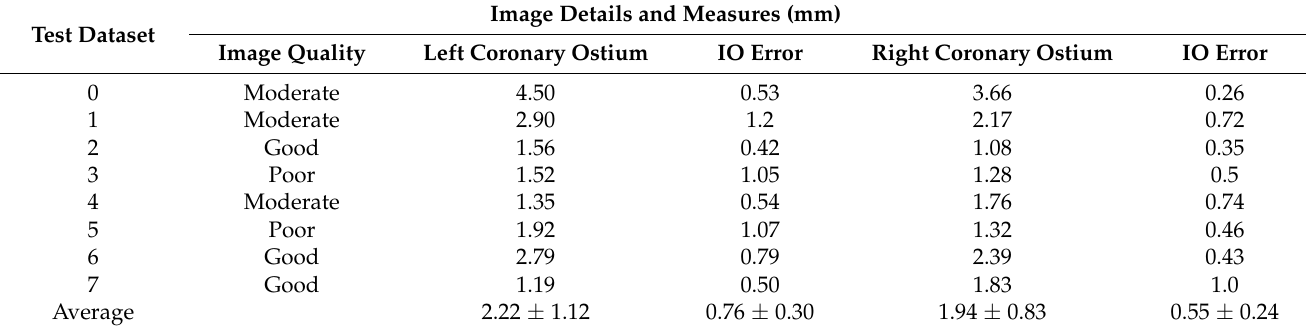
Table 2. The detailed test image cases with IO error and the results of identification of two coronary ostia by EsseNet with dueling DQN.; IO, inter-observer; DQN, deep Q-learning. Test